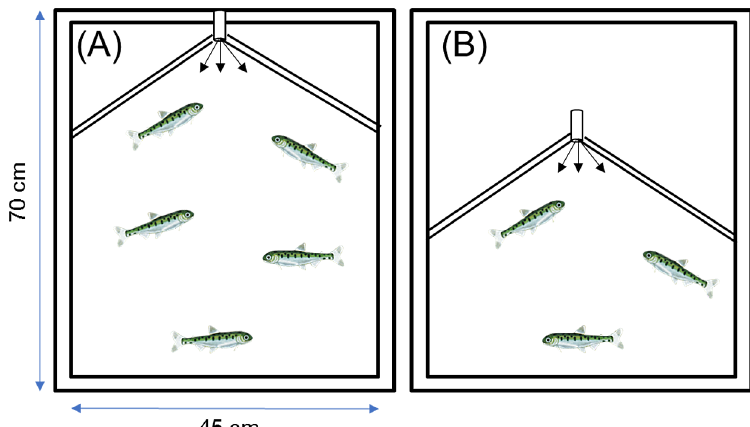
Fig. 1. Schematic representation of the experimental aquaria used for the dominance experiments with Atlantic salmon in 2016 and 2017. (A) Prior to and (B) after removal of the dominant individual(s) when the experimental area was reduced to minimize the density